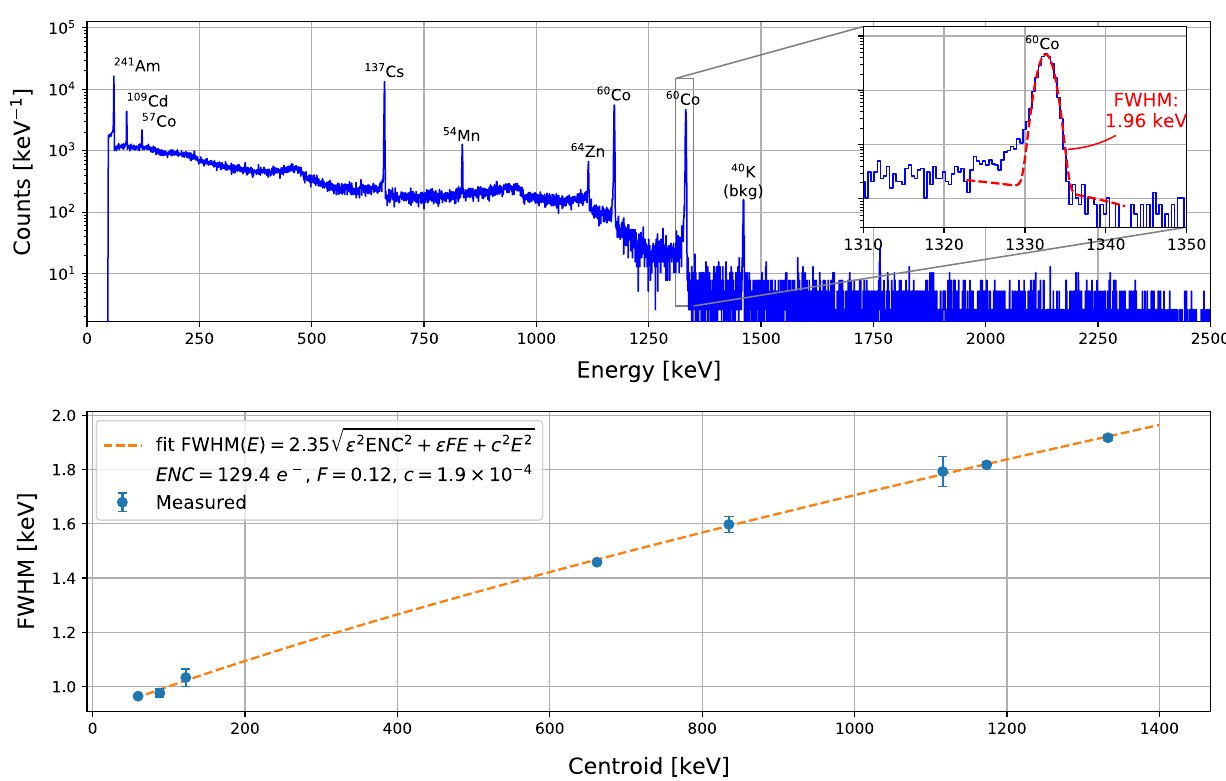
in the upper left corner is also included. It allows to determine the noise level and the Fano factor for Ge – see the text for a detailed explanation